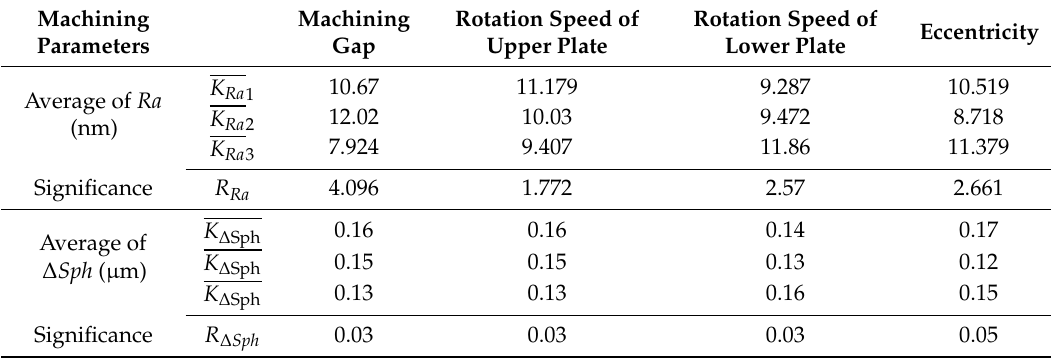
Table 5. Analysis of the significance of the cutting